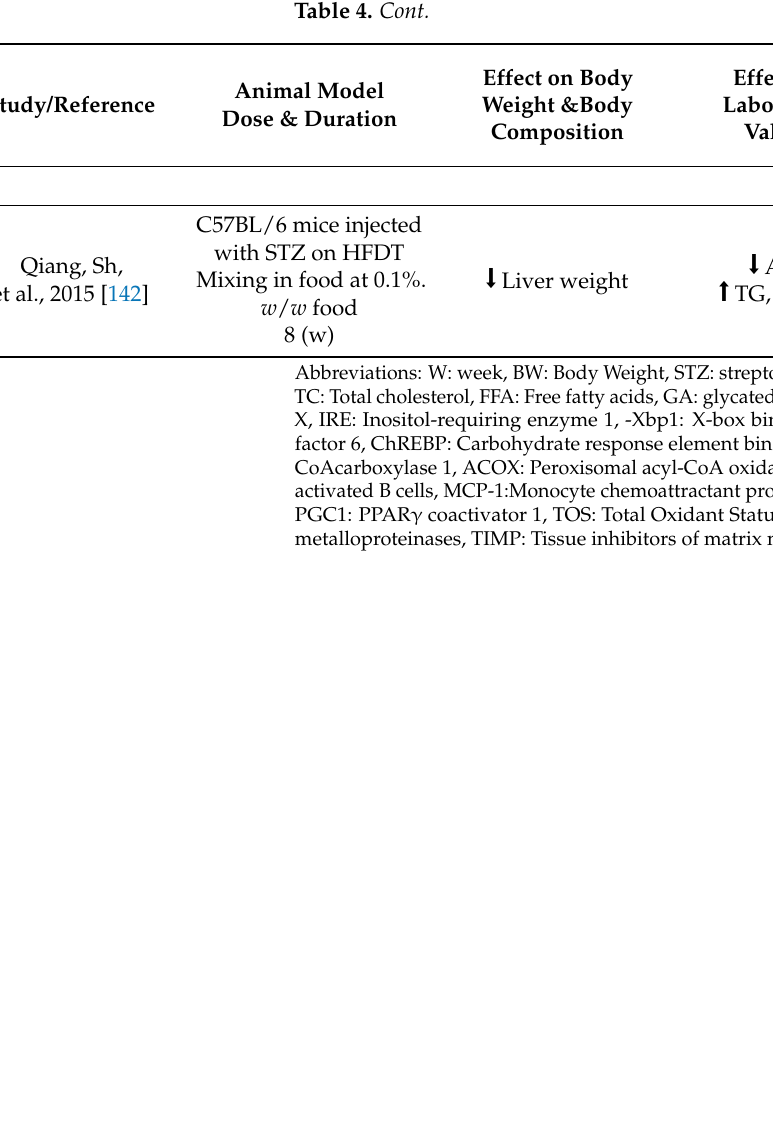
Table 1. Key animal studies regarding the impact of empagliflozin on NAFLD/NASH.